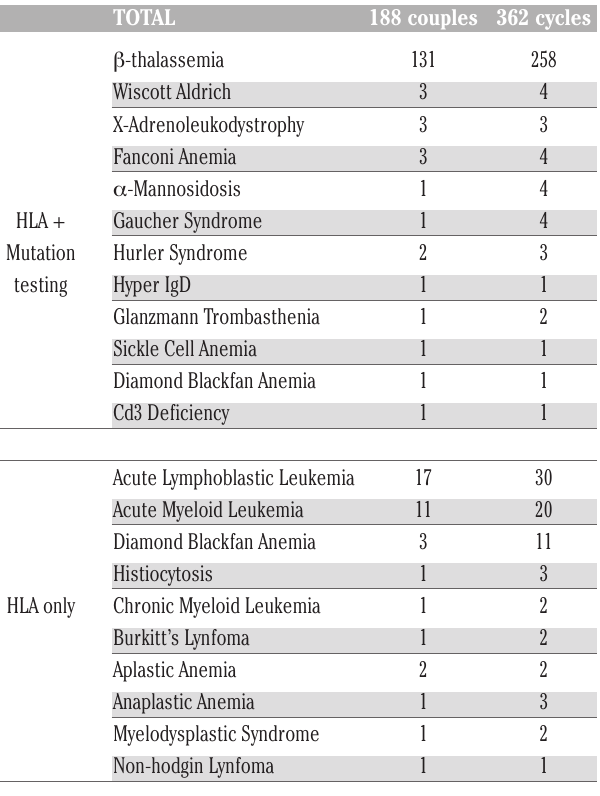
Table 4. The list of diseases and the number of patients who have complete cure after